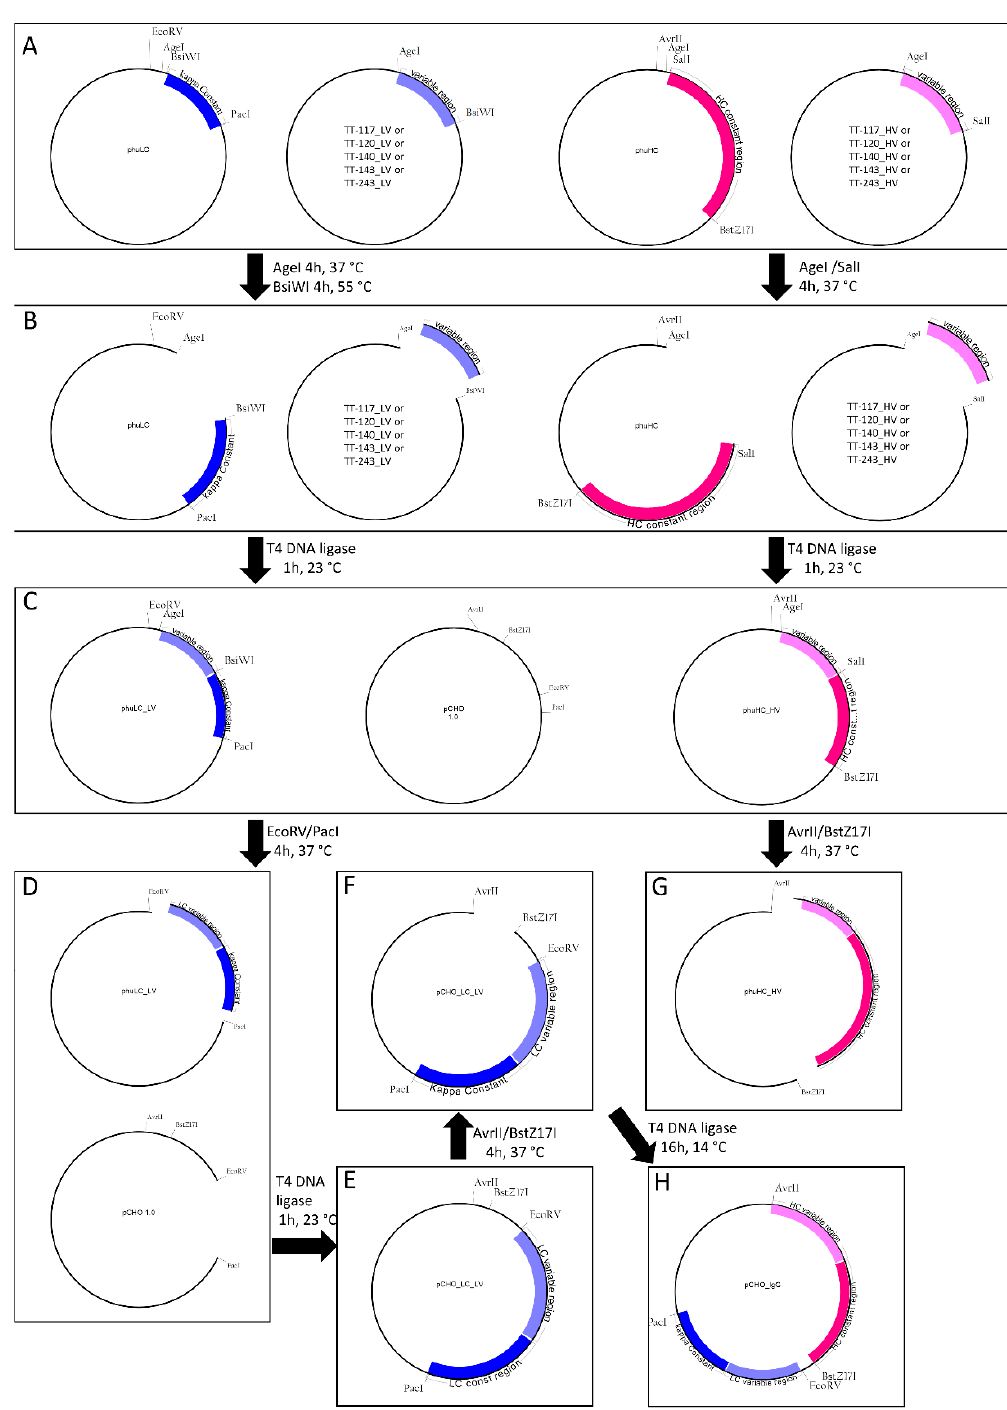
Figure 1. Construction of the expression vector. ( A ) Transportation vectors synthesized by GeneArt contain constant regions and vectors containing variable regions. ( B ) Digestion by AgeI-HF and SalI-HF for heavy chain cloning and Age-HF and BsiWI for light chain cloning. ( C ) Ligation results in vectors with a complete heavy or light chain. ( D ) Digestion with EcoRV and PacI for light chain release and preparation of vector pCHO1.0 for cloning. ( E ) Ligation of complete light chain released in D into pCHO 1.0. ( F ) Digestion with AvrII and BstZ17I of pCHO_LC_LV. ( G ) Digestion with AvrII and BstZ17I for complete heavy chain release. ( H ) Ligation of released complete heavy chain into linear pCHO_LC_LV and the complete expression vector.